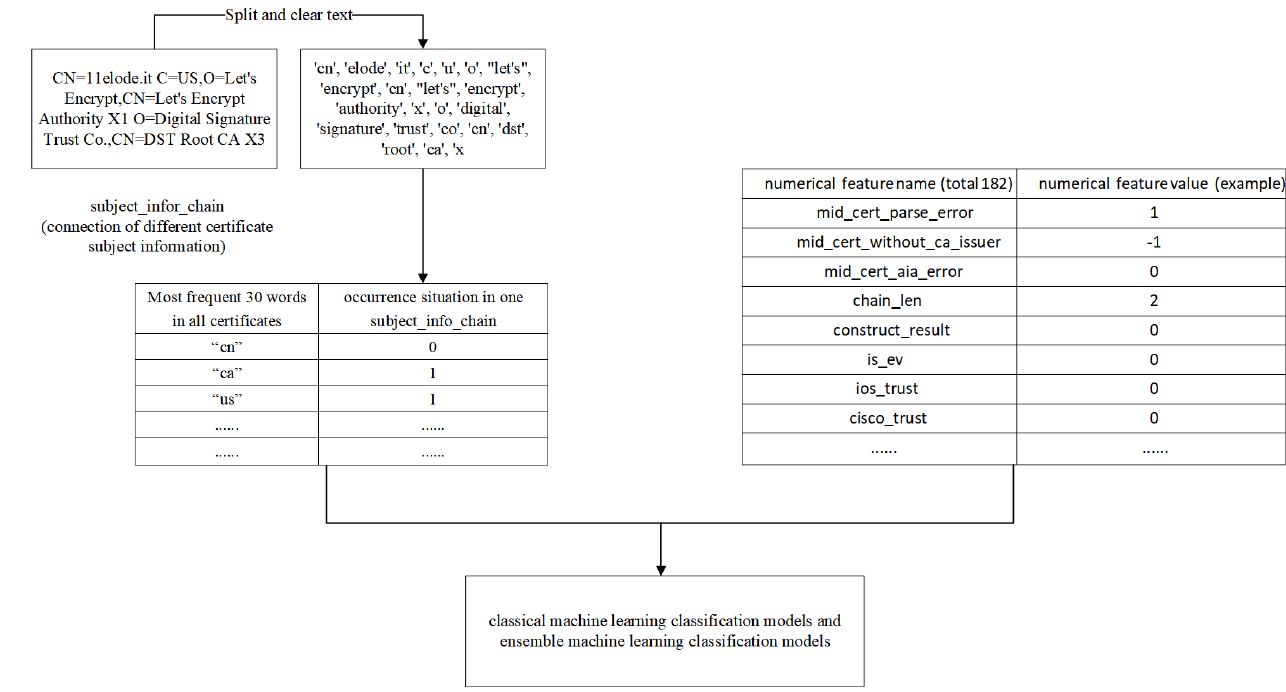
Figure 2. The data processing of classical and ensemble